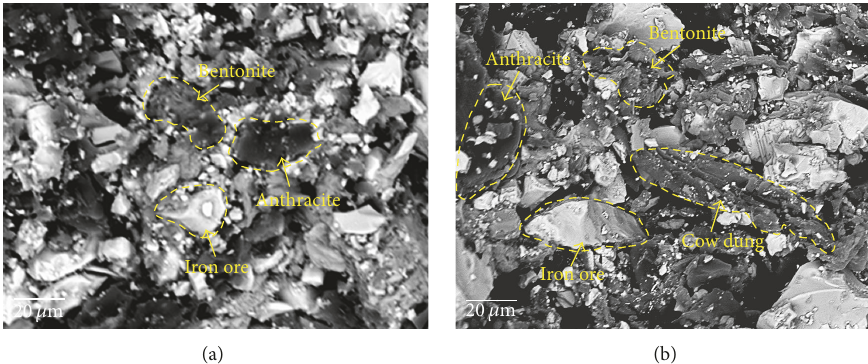
Figure 4: SEM back scattered images of different carbon-bearing pellets after drying. (a) Dry pellet sample without cow dung; (b) dry pellet sample with 14.0% cow dung.